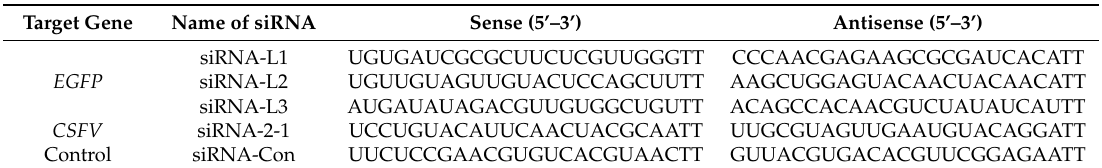
Table 1. The target genes, names and corresponding sequences of